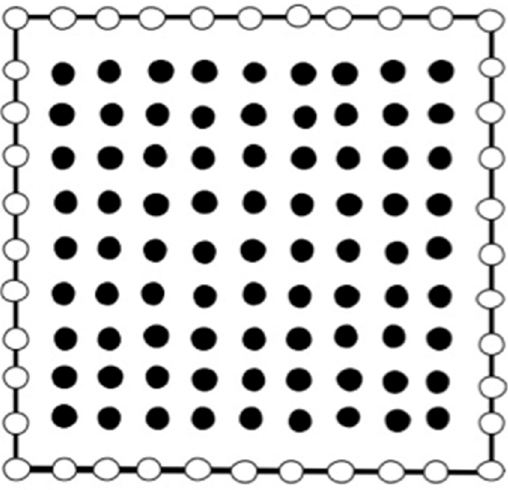
Figure 1. Boundary element model of the considered problem.